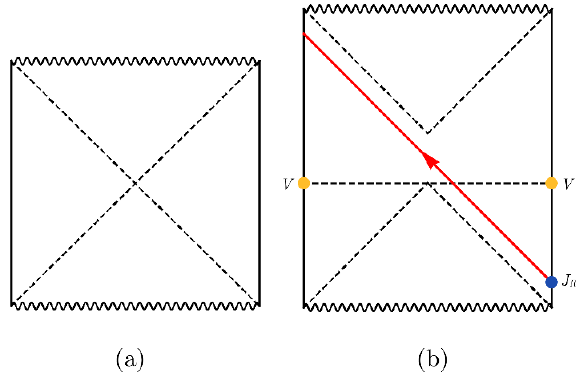
Figure 8 . (a): Penrose diagram of an eternal black hole. The two boundaries are causally discon- nected. (b): in the picture of [1, 2], presence of V deforms the bulk geometry, especially the causal structure, allowing signals to pass from right to left, now following a timelike